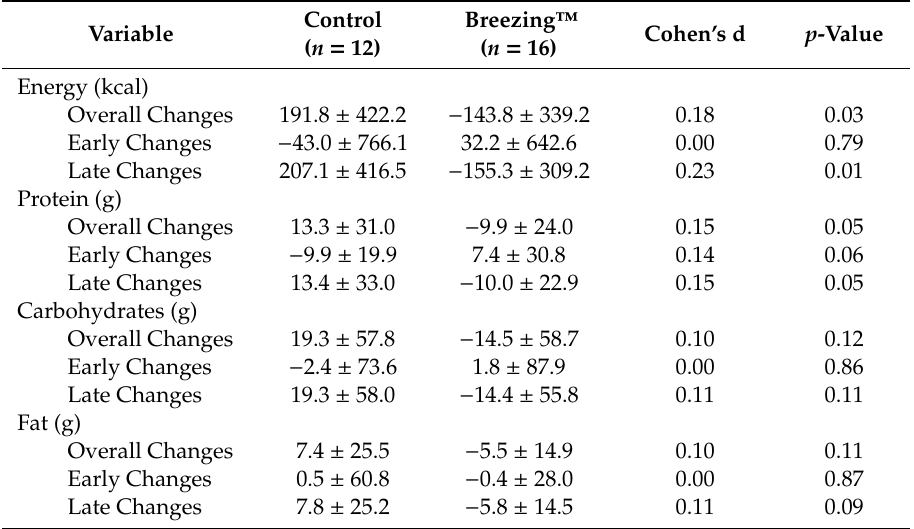
Table 4. Mean ± SD Group Di ff erences for Overall, Late, and Early Changes in Daily Macronutrient Intakes (N =